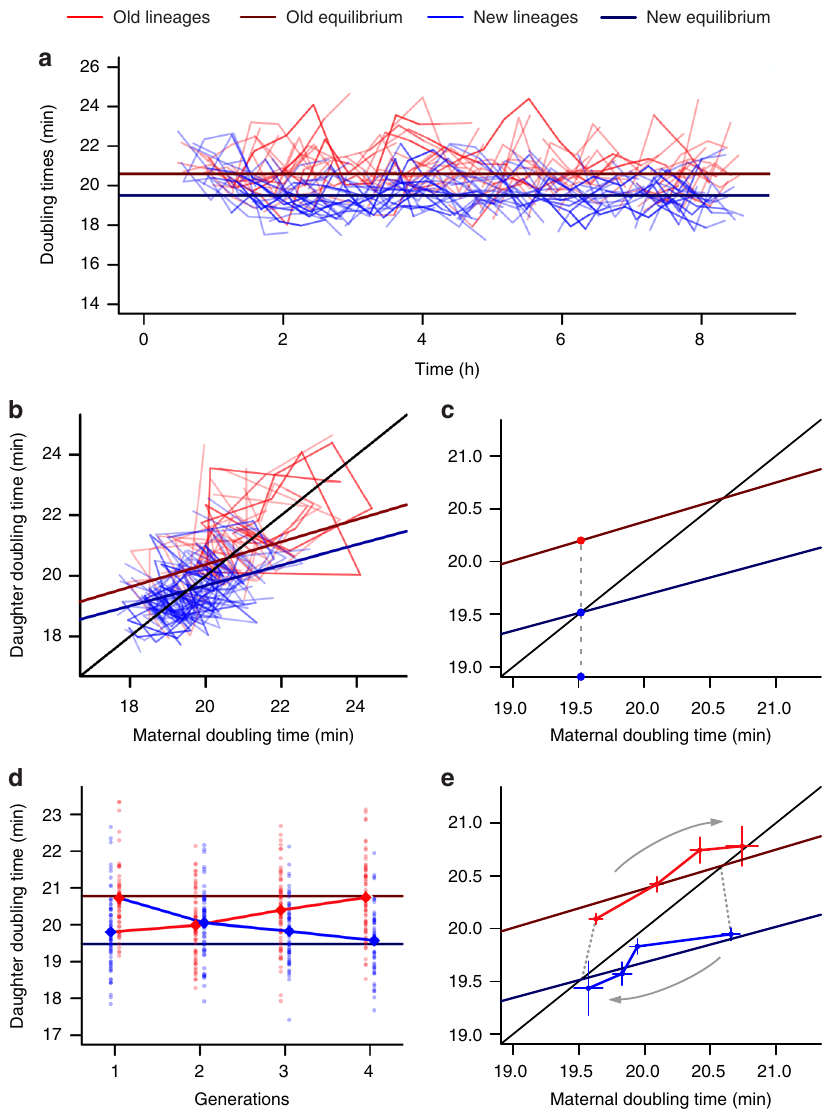
Fig. 4 New and old daughters reach equilibrium in the daughter device. a New (19.365±0.907, n = 158) and old lineages (21.177±1.237, n = 116), represented by those inheriting the same pole for at least 4 generations, exhibited stably distinct doubling times ( t = 13.354, df = 200.66, p <0.001, one-tailed t -test) over time. b By following these lineages on the phase plane, we determined the equilibrium points based on the linear relationships between T0 and T1 or T2. A two- way ANCOVA revealed a signi fi cant effect of T0 (F = 460.3, p <0.001) and age (F = 334.2, p <0.001) on daughter doubling times ( n = 2400), with both linear models displaying similar slope (F = 1.051, p = 0.305). c Graphical representation of two daughters born from a mother at T1 equilibrium. Although its new daughter remains at equilibrium, its old daughter displays a longer doubling time. d Old lineages born from T1 equilibrium (generation 1) converge towards T2 equilibrium over three generations. The same is observed for new lineages born from T2 equilibrium, which converge towards T1 equilibrium over time. e In the phase plane, we can observe the trajectory of cells born from the opposite equilibrium as they consecutively approach the equilibrium that matches their polarity. Error bars represent mean±SEM. Old lineage n = 370, 179, 70, 30; new lineage n = 291, 139, 62, 24